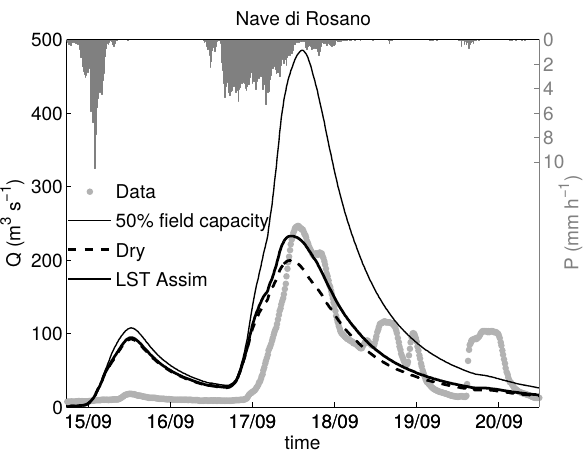
Figure 7. Hydrographs at Nave di Rosano measurement station for the test event of LST assimilation. Flow observations are gray dots, predictions initialized with a complete dry soil, soil saturation level equal to 50% of field capacity, and soil moisture estimated from the assimilation of LST, are the solid, dashed and solid thick line